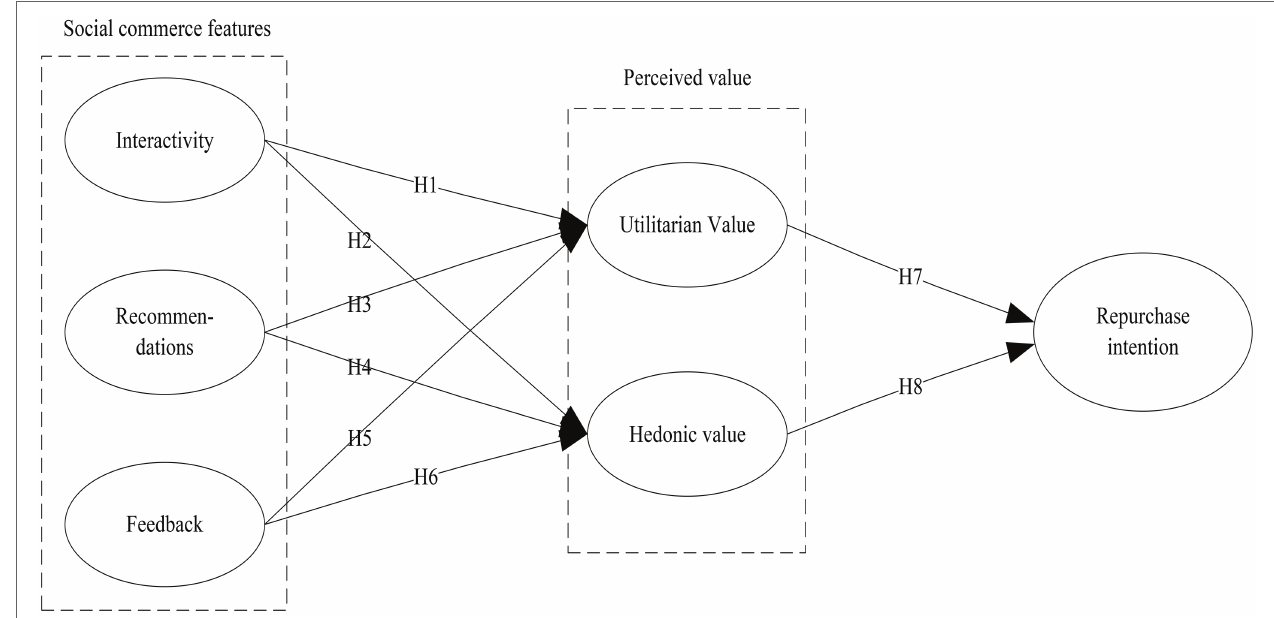
FIGURE 1 | Research